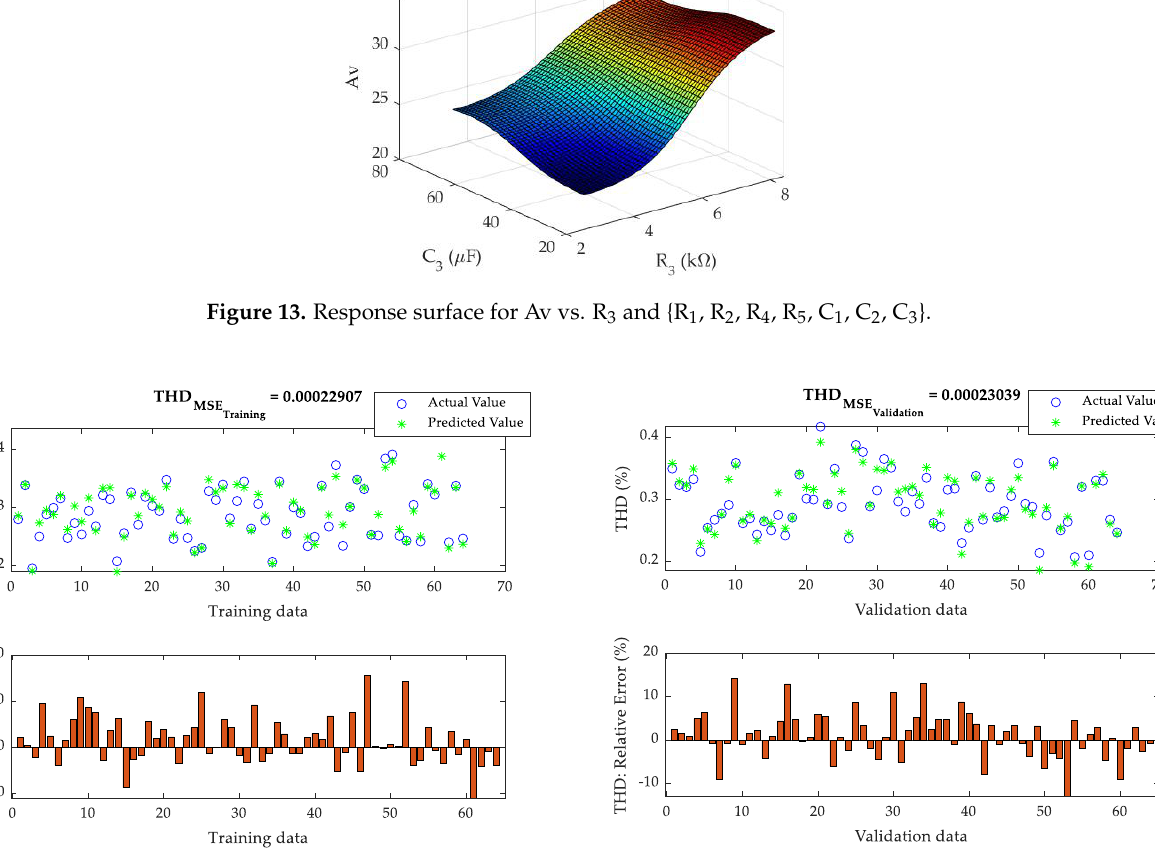
( b ) Figure 15. Results of the tuned FIS in the second step for THD: ( a ) training data; ( b ) validation data.